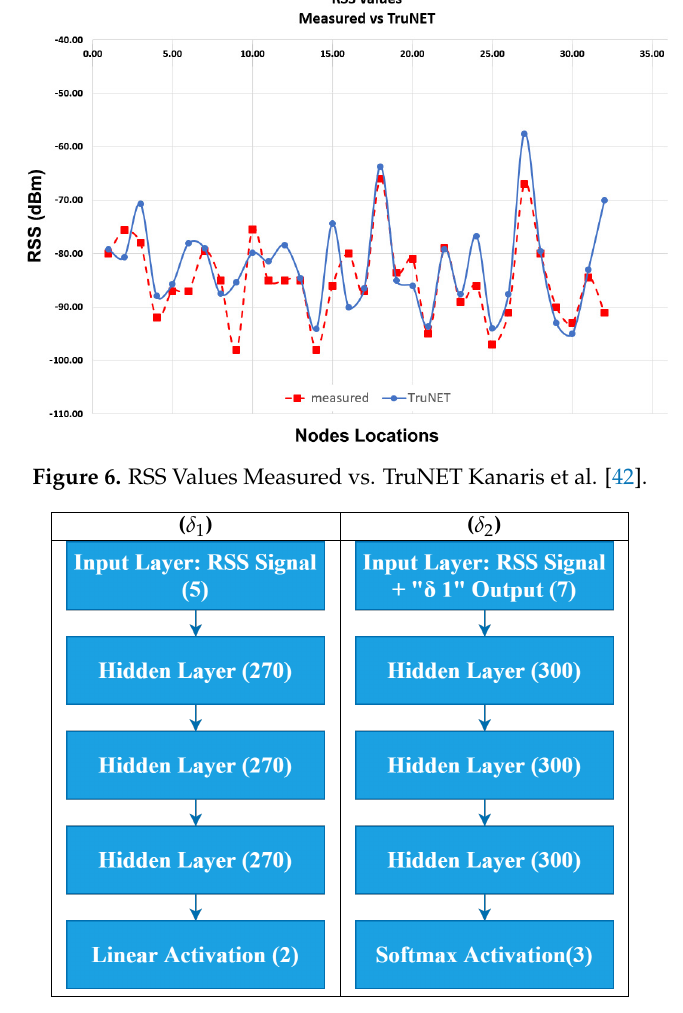
Figure 7. Layers of DELTA Architecture